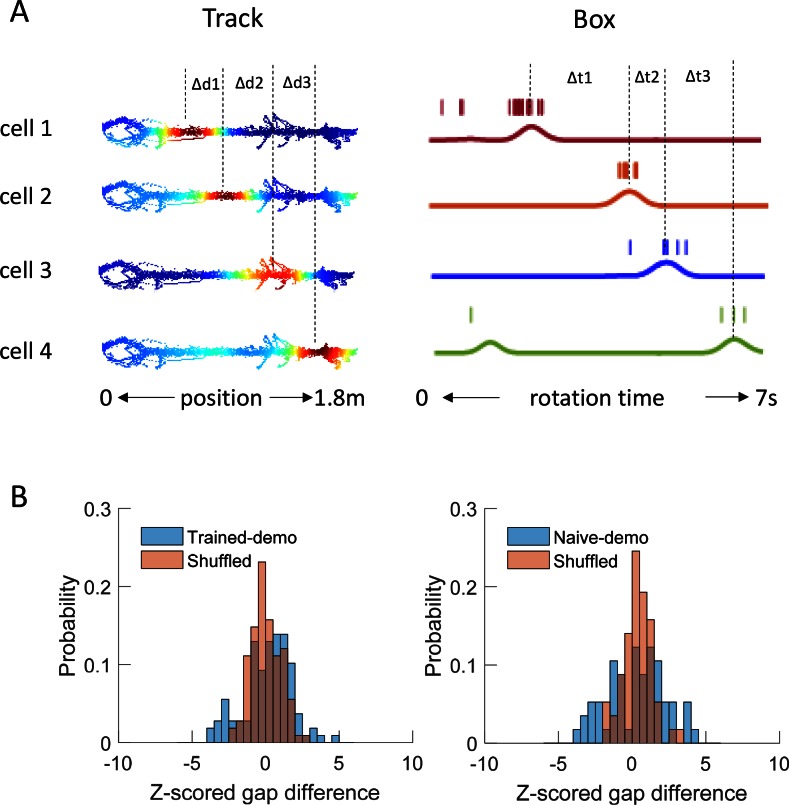
Precise firing timing among common cells did not match between matching sequences in the box and template sequences on the track trajectories.(A) Fire rate maps of 4 example cells on a trajectory of the track (as in Figure 3A) and spike trains of the same cells within a matching sequence in the box (as in Figure 4A). On the track, the peak location of each map was identified. The distance between peak locations of a pair of common cells with neighboring peaks (∆d) was computed and transformed to a time gap according to the animal’s mean speed on the trajectory. For the same pair of cells in a rotation event, their spike trains were convolved into instantaneous firing rate curves (solid lines) and peak firing times were identified. The time gap between the peal times (∆t) was computed. Both ∆d, ∆t were rescaled such that the total lengths of the trajectory running and rotation event were equalized to 1. The absolute difference of these two time gaps (gap difference: |∆d − ∆t|) was averaged over all pairs in a matching sequence. (B) Distributions of gap difference (blue) for all matching sequences in Trained-demo (N = 36) or Naïve-demo (N = 19) box sessions, z-scored relative to those obtained from randomly shuffled matching sequences (independent shifting of each cell’s firing timing within a matching sequence but with firing orders intact). For comparison, the distributions of the z-scored gap difference of a sample of shuffled sequences are shown (red). t = 0.08, p=0.98 between Trained-demo and Shuffled (t-test), and t = 0.7, p=0.48 between Naïve demo and Shuffled.